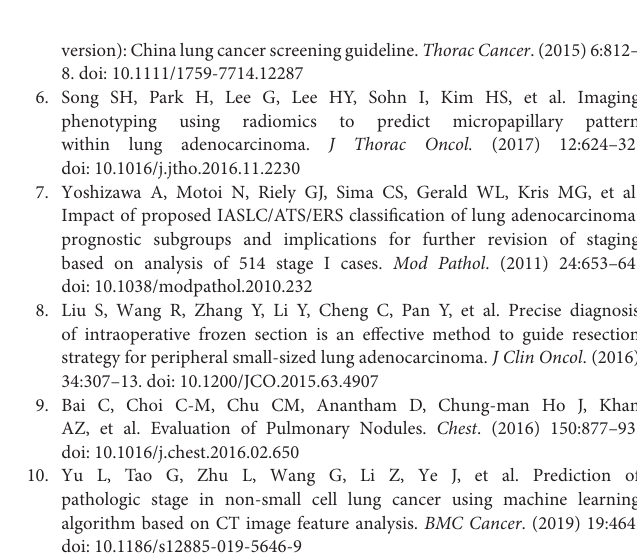
Supplementary Figure 1 | The loss function curve and accuracy curve for two models in the 2-Class classification task. Supplementary Figure 2 | The loss function curve and accuracy curve for two models in the 3-Class classification